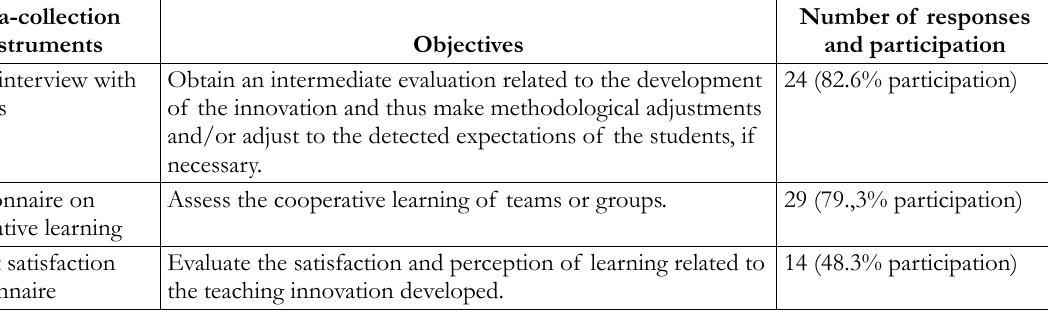
Table 3. Data-collecting instruments within the framework of the innovation project